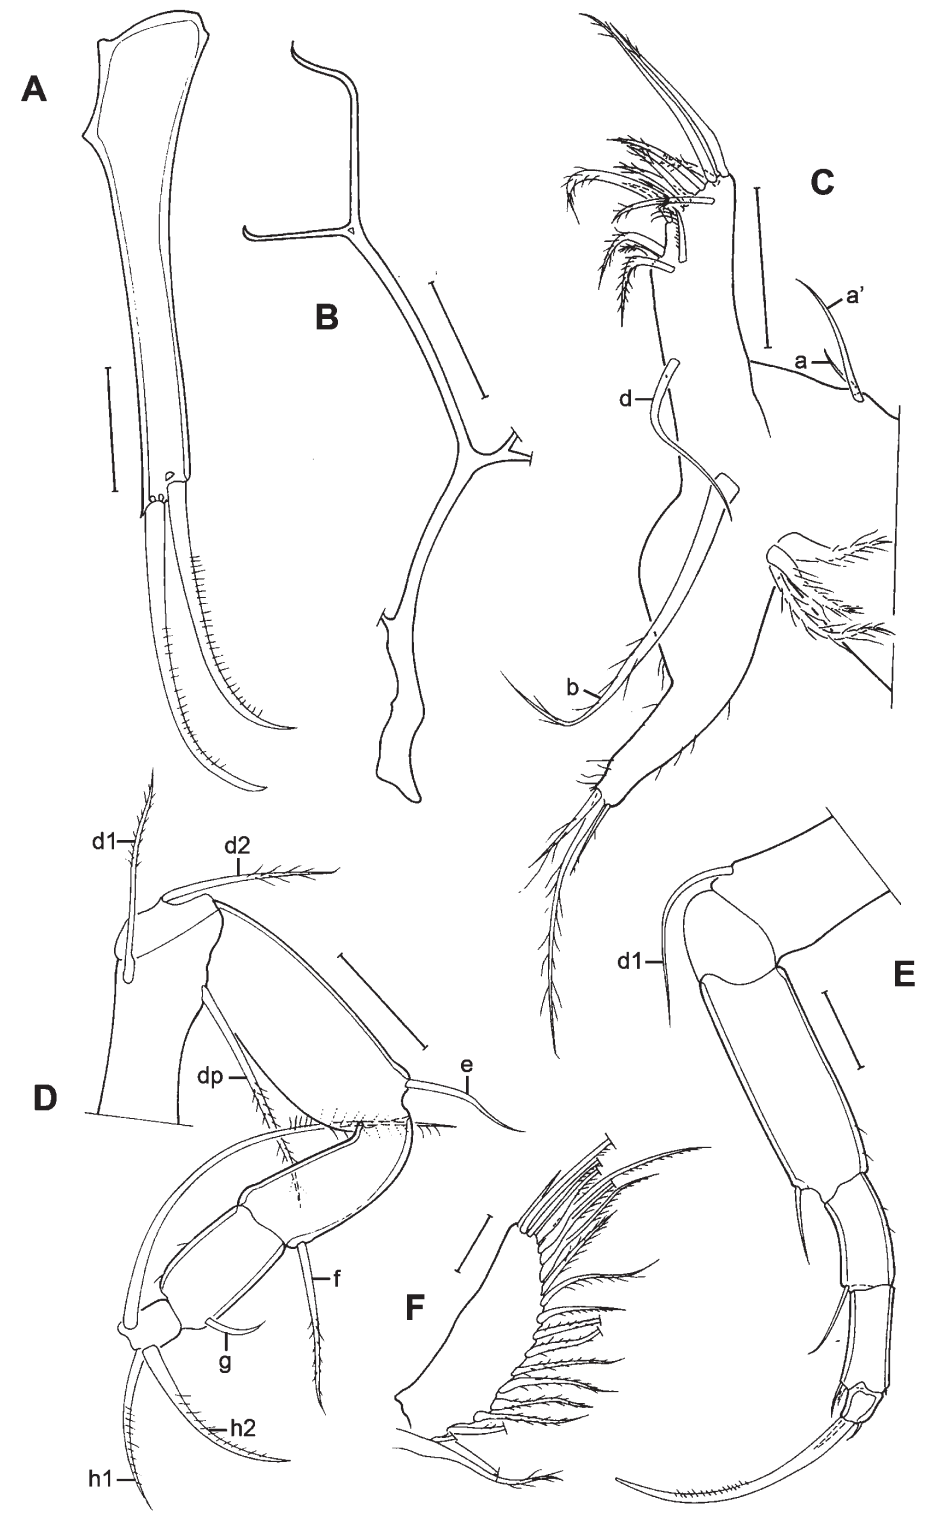
Fig. 12. Candobrasilopsis brasiliensis (Sars, 1901) comb. nov., limbs (♀). A . Caudal ramus (MZUSP.28125). B . Attachment of the caudal ramus (MZUSP.28125). C . T1 (OC.3300). D . T3 (OC.3300). E . T2 (MZUSP.28125). F . Mx1, respiratory plate (OC.3299). Scale bars: A-F = 50